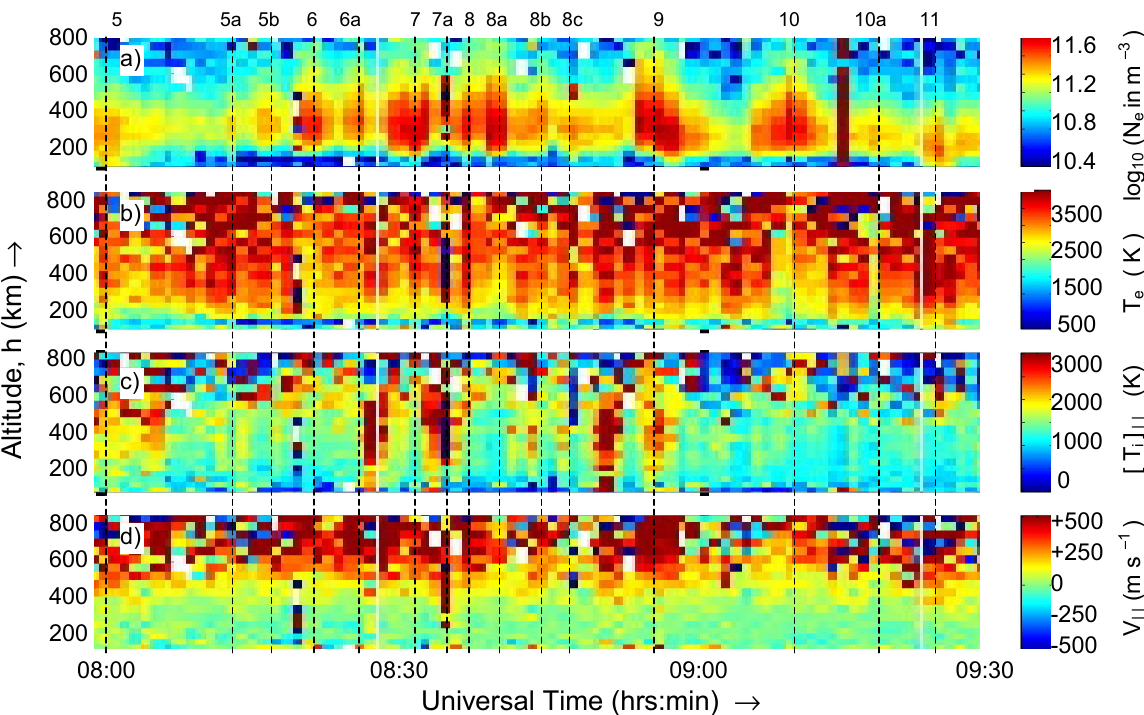
Fig. 6. One-minute post-integrations of the data from the field-aligned ESR beam for 08:00–09:30. Altitude profiles are shown for (from top to bottom): (a) the plasma concentration, N e ; (b) the electron temperature, T e ; (c) the field-aligned ion temperature, [ T i ] k and (d) the field-aligned (line-of-sight) ion velocity, V k . The dashed lines mark the centre of events 5, 6, 7, 8, 9, 10, and 11 in this interval, as defined in Fig. 5. These higher-resolution N e data in the field-aligned direction reveal additional events 5a, 5b, 6a, 7a, 8a, 8b, 8c, and